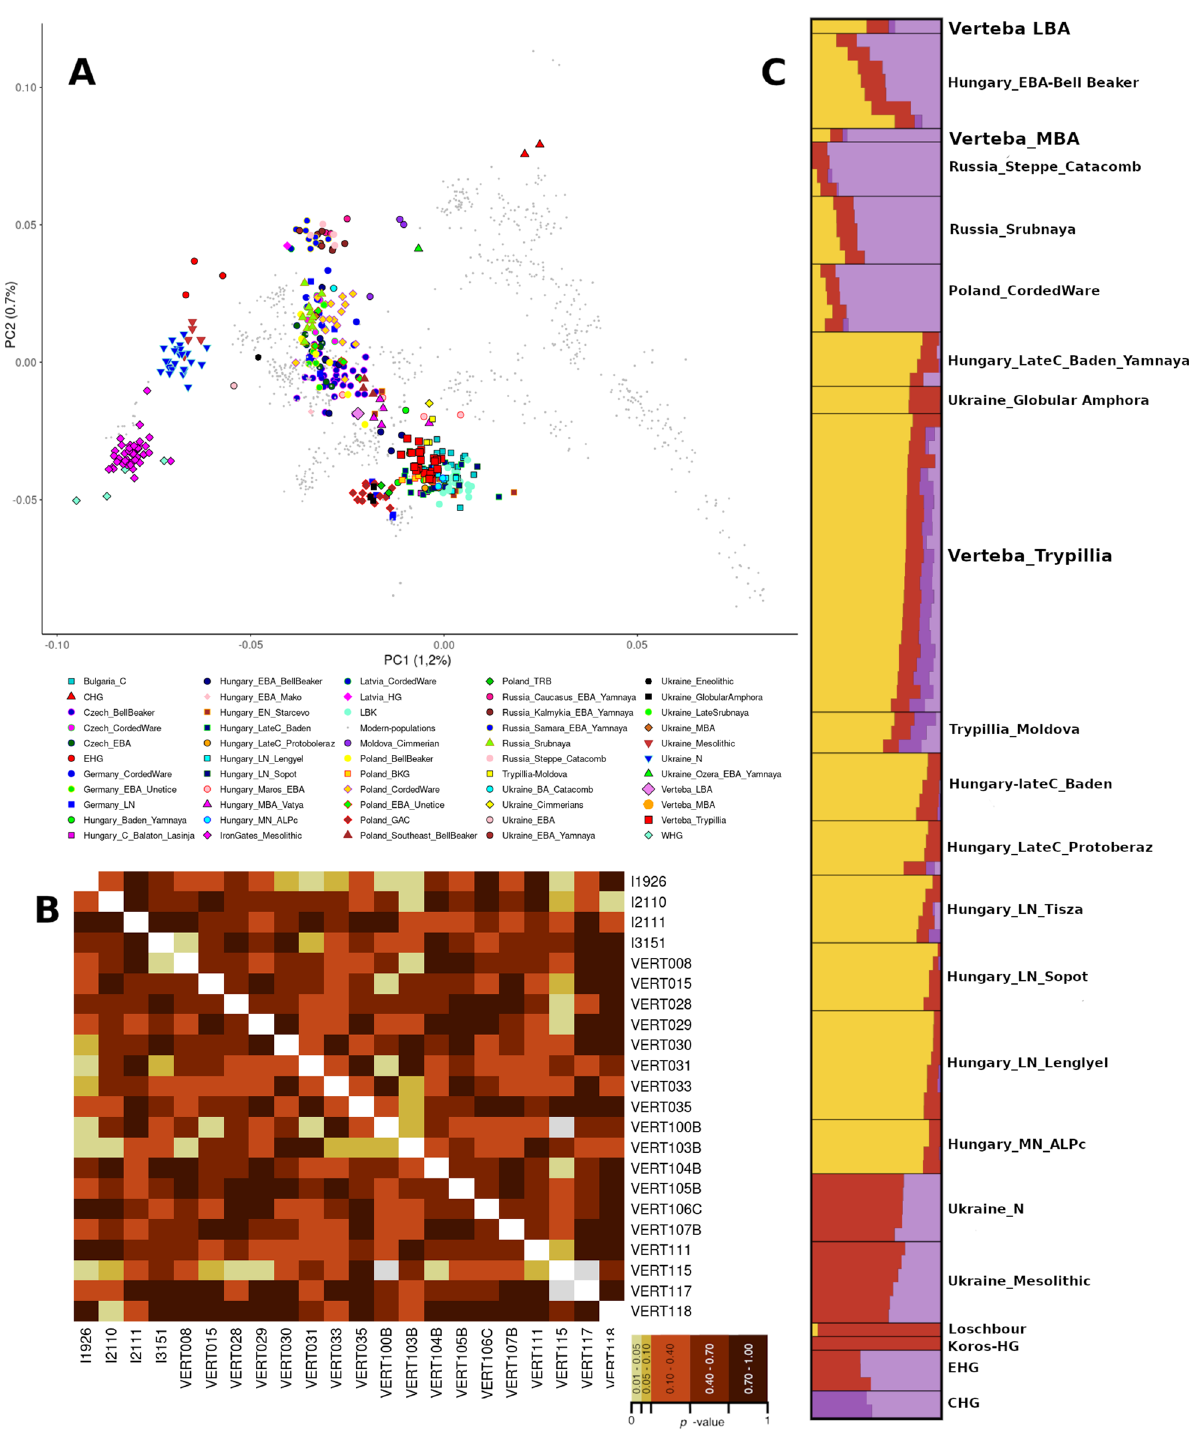
Figure 2. Population genetics: ( A ) PCA built with modern European populations in which Neolithic and Bronze Age populations of Eastern Europe have been projected. It is observed that the Verteba_Trypillia individuals are located within the European Neolithic populations genetic diversity while the Verteba_MBA and Verteba_LBA individuals are located close to other Bronze Age individuals suggesting genetic similarity. ( B ) ADMIXTURE analysis of the most representative populations included in the analysis (K = 4). The different colors represent the source ancestries of the studied individuals: Yellow represents Anatolia_N related ancestry, Red represents WHG related ancestry and the purple colors represent Steppe related ancestries, each individual is represented by the proportions of these ancestries. ( C ) Heatmap built with 1 × 1 qpWave results of the Verteba_Trypillia individuals, where no individuals show a sign to be clustered in a different population suggesting that these individuals belong to the same genetic